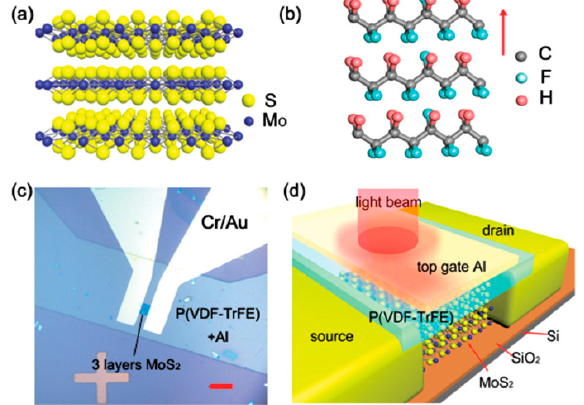
Figure 63. Fabrication and structure of few-layer MoS 2 photodetector. ( a ) Schematic structure of triple-layer MoS 2 ; ( b ) Schematic structure of P(VDF-TrFE) ferroelectric polymer; ( c ) Optical image of the whole device; ( d ) 3D schematic view of the triple-layer MoS 2 photodetector with monochromatic light